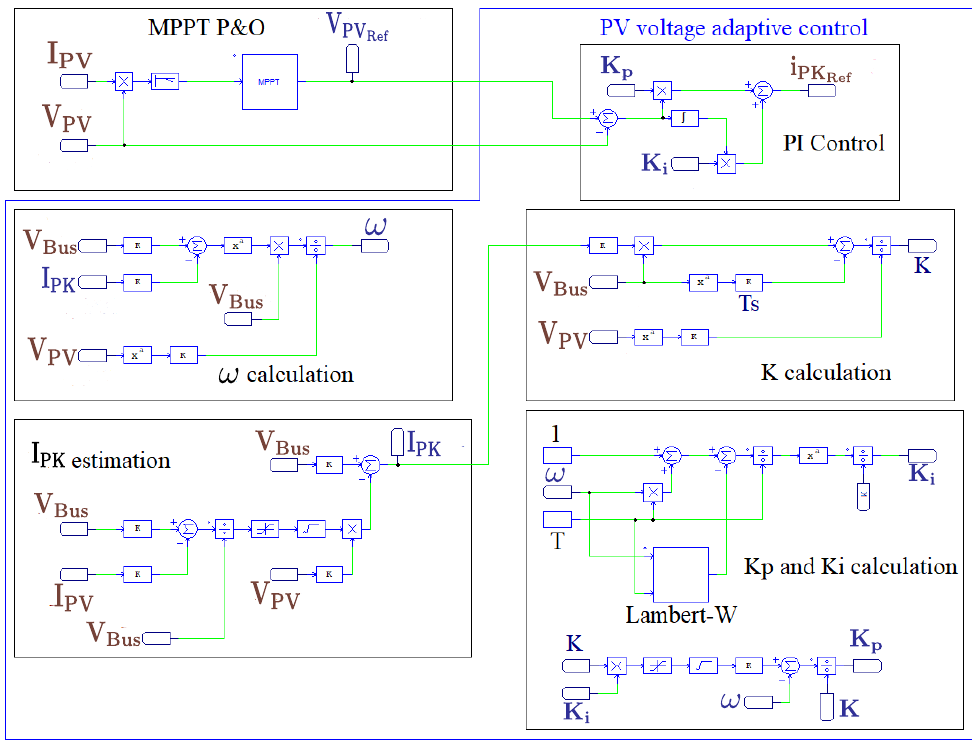
Figure 14. MPPT and v PV control